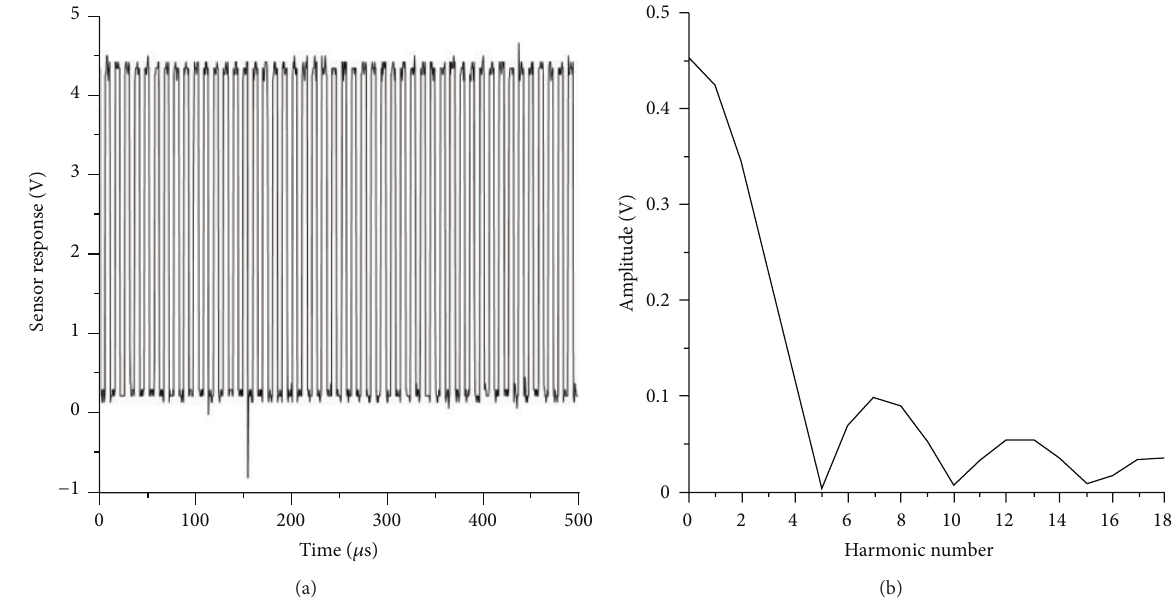
Figure 7: Response mortar tile. (a) Response of the oscillator. (b) Analysis gives harmonics of the sensor